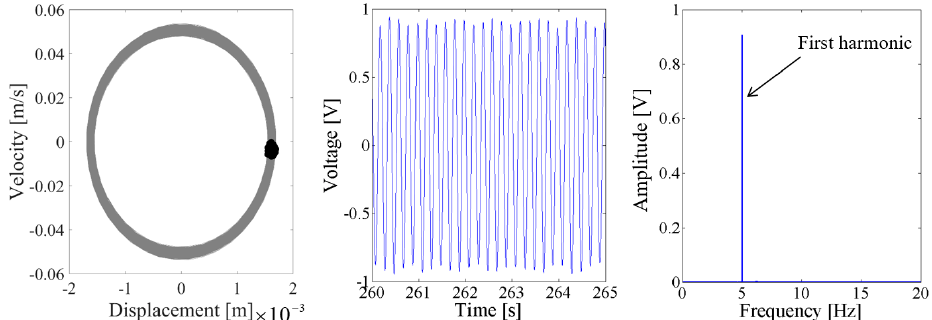
Figure 14. Dynamic responses of the coupled harvester-1 for the excitation level of 0.1 g.